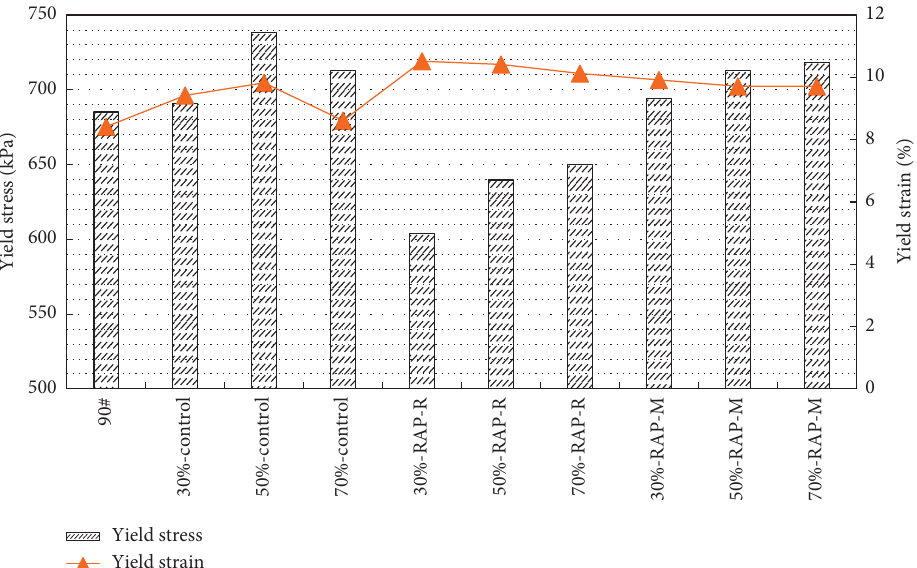
Figure 23: Comparison between yield stress and yield strain of various recycled